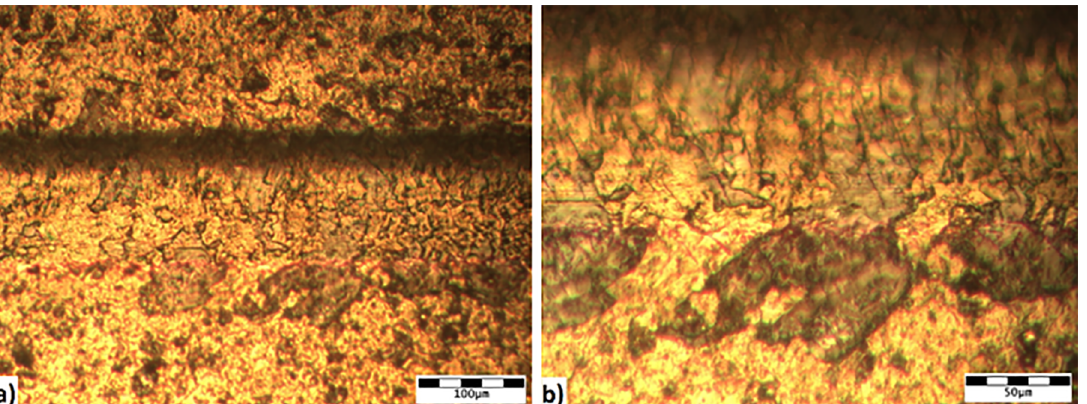
Figure 6. Scratch Test critical load 200x: a) Cond. I 20 N, b) Cond. II 5N.